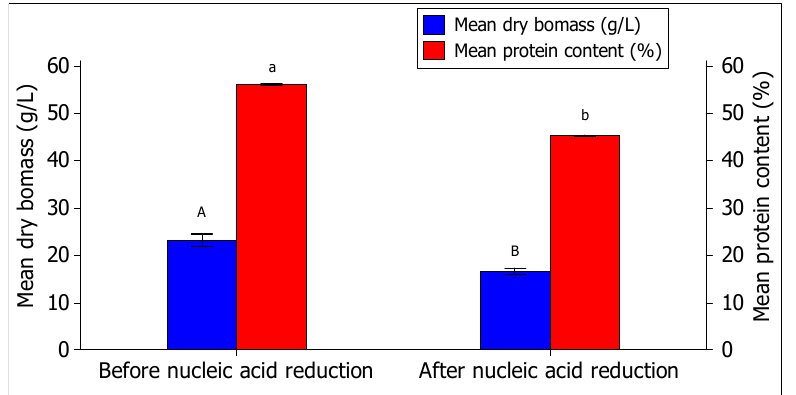
Figure 6. Effect of nucleic acid reduction treatment on the dry biomass and protein content of SCP produced from papaya peel using mixed culture of palmyrah toddy. Comparisons of mean were performed with Tukey’s multiple comparison test at p < 0.05. Different uppercase and lowercase letters indicate the significant differences in dry biomass and protein content, respectively. A,B: Dry biomass; a,b: Protein